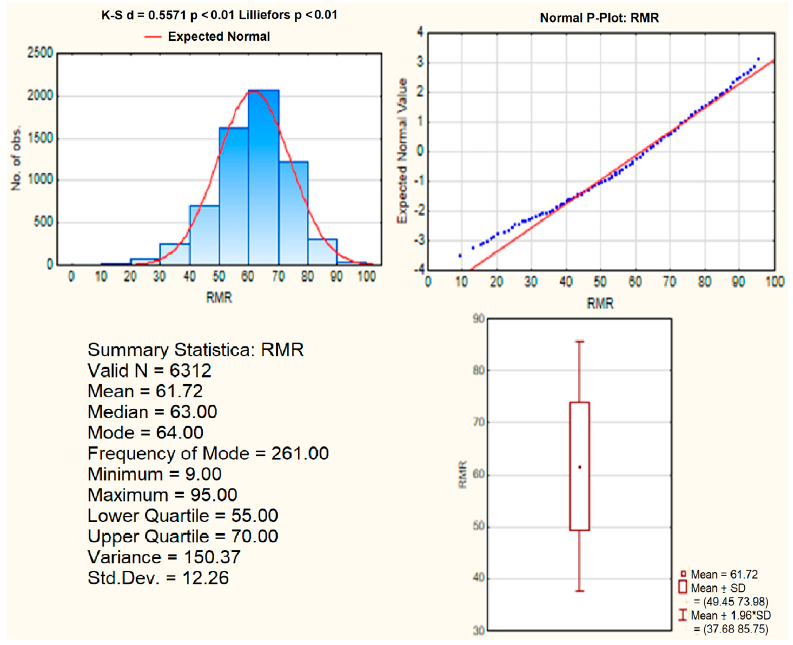
Figure 7. Distribution of rock mass rating (RMR) values observed in the six case studies: Kolmogorov-Smirnov and P-Plot tests. Figure 8 specifies the RMR results recorded for the following face advances ( n + 1, ..., n + 5) after